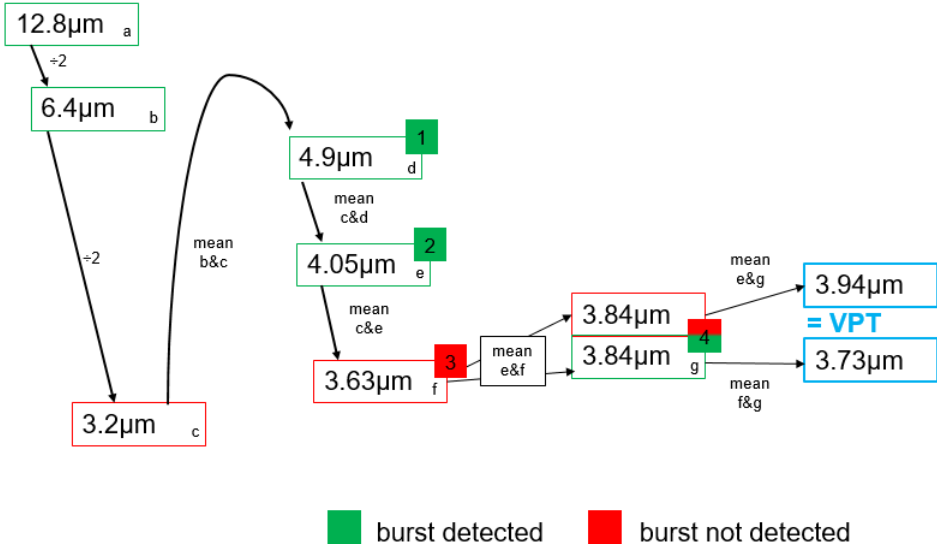
Figure A1. Exemplary procedure for determining VPT. The algorithm is started by the examiner with a vibration burst above the participants’ individual threshold ( a ). The subject signals the perception of the initial stimulus by pressing a button. The algorithm then automatically halves the amplitude of the next stimulus to be tested ( b ) until the first vibration can no longer be perceived ( c ). The algorithm then averages the last perceived stimulus ( b ) and the last stimulus that was not felt ( c ) and continues determining the VPT using this averaged amplitude ( d ). After one vibration stimulus is not felt ( c ), the algorithm automatically tests four more stimuli according to the procedure just described ( d – g ). VPT is then the mean of the last recognized ( e or g ) and the last unperceived ( f or g ) vibration stimulus.